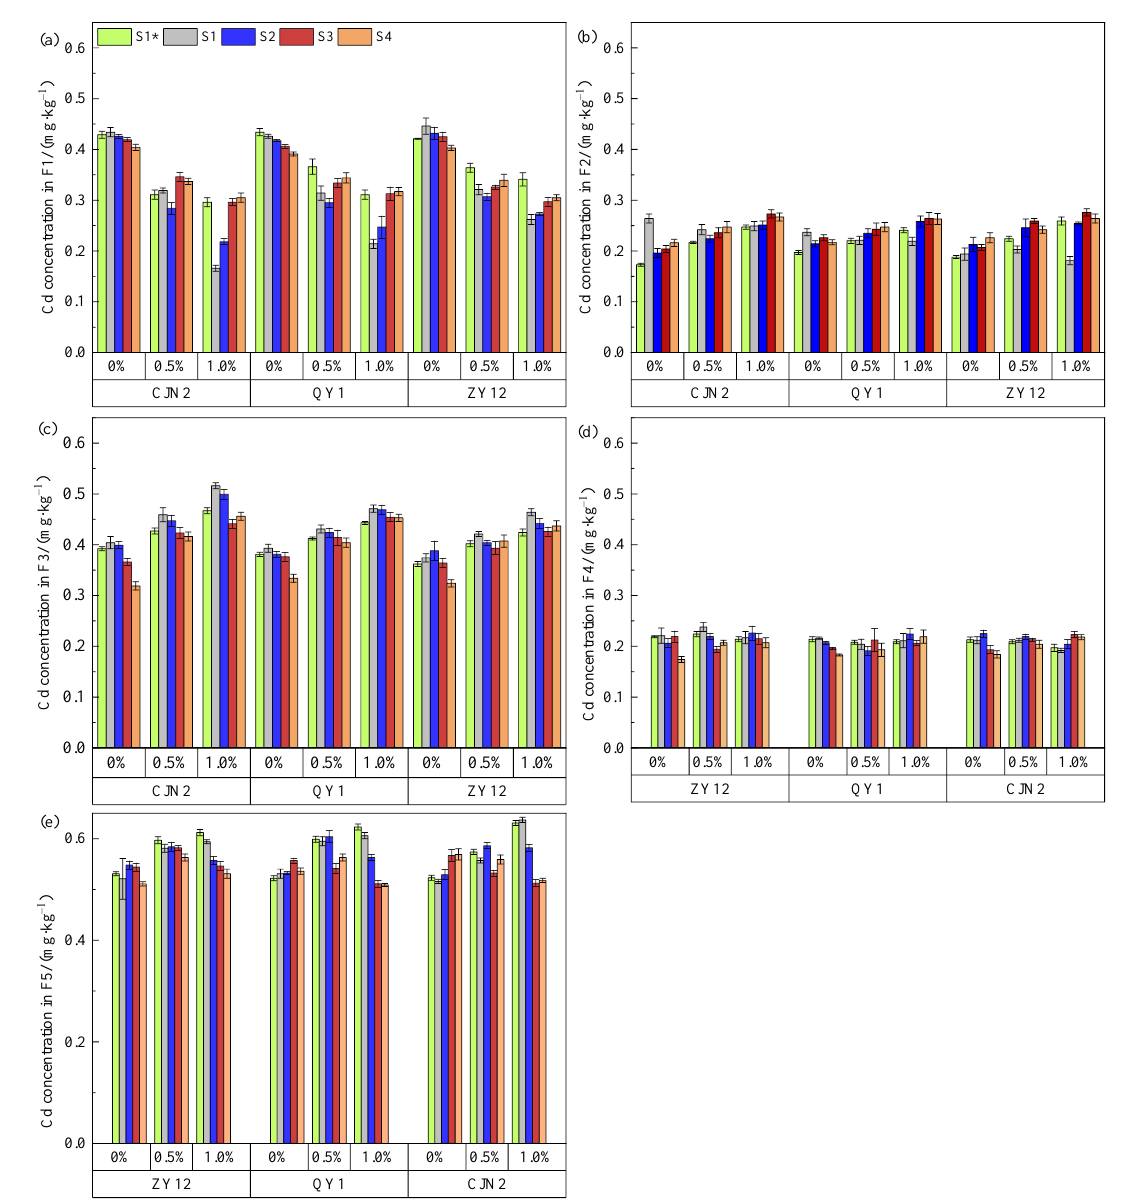
Figure 7. Effect of red mud (RM) on concentrations of Cd fractions in soil zones of rhizoboxes. ( a ) Cd concentration in F1; ( b ) Cd concentration in F2; ( c ) Cd concentration in F3; ( d ) Cd concentration in F4; ( e ) Cd concentration in F5. S1* indicates different soil zones in rhizoboxes at tillering stage; S1, S2, S3, S4 indicates different soil zones in rhizoboxes at bolting